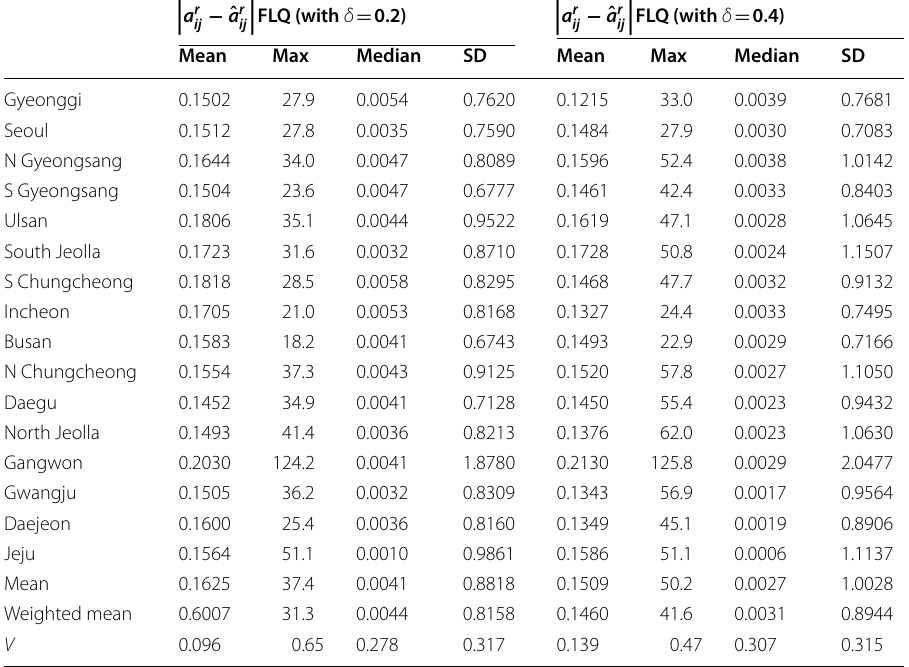
Table 9 Statistics illustrating how the absolute differences ( estimated input coefficients vary with changes in the assumed value of